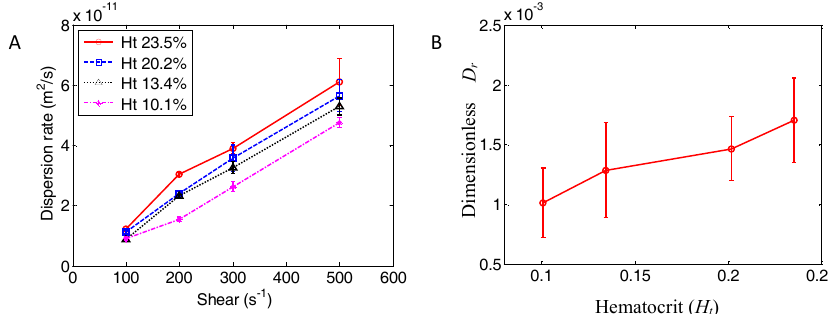
Figure 7. Dispersion rate of NPs in blood flow. ( A ) NP dispersion rate at different hematocrit (Ht) and shear rates; ( B ) relationship between dimensionless dispersion rate ( D r ) and hematocrit ( H t ). Error bars show the standard variance from three samples.